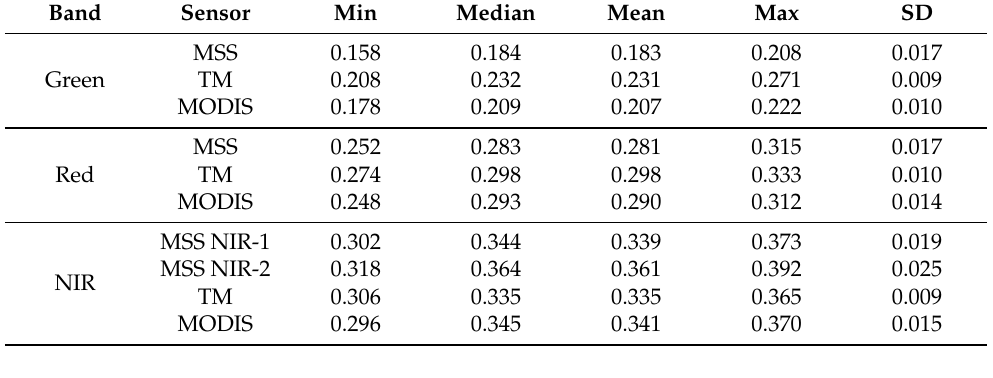
Table 9. Statistics of time-series reflectance of MSS, TM, and MODIS in ROI 5 (ROI 5: desert).